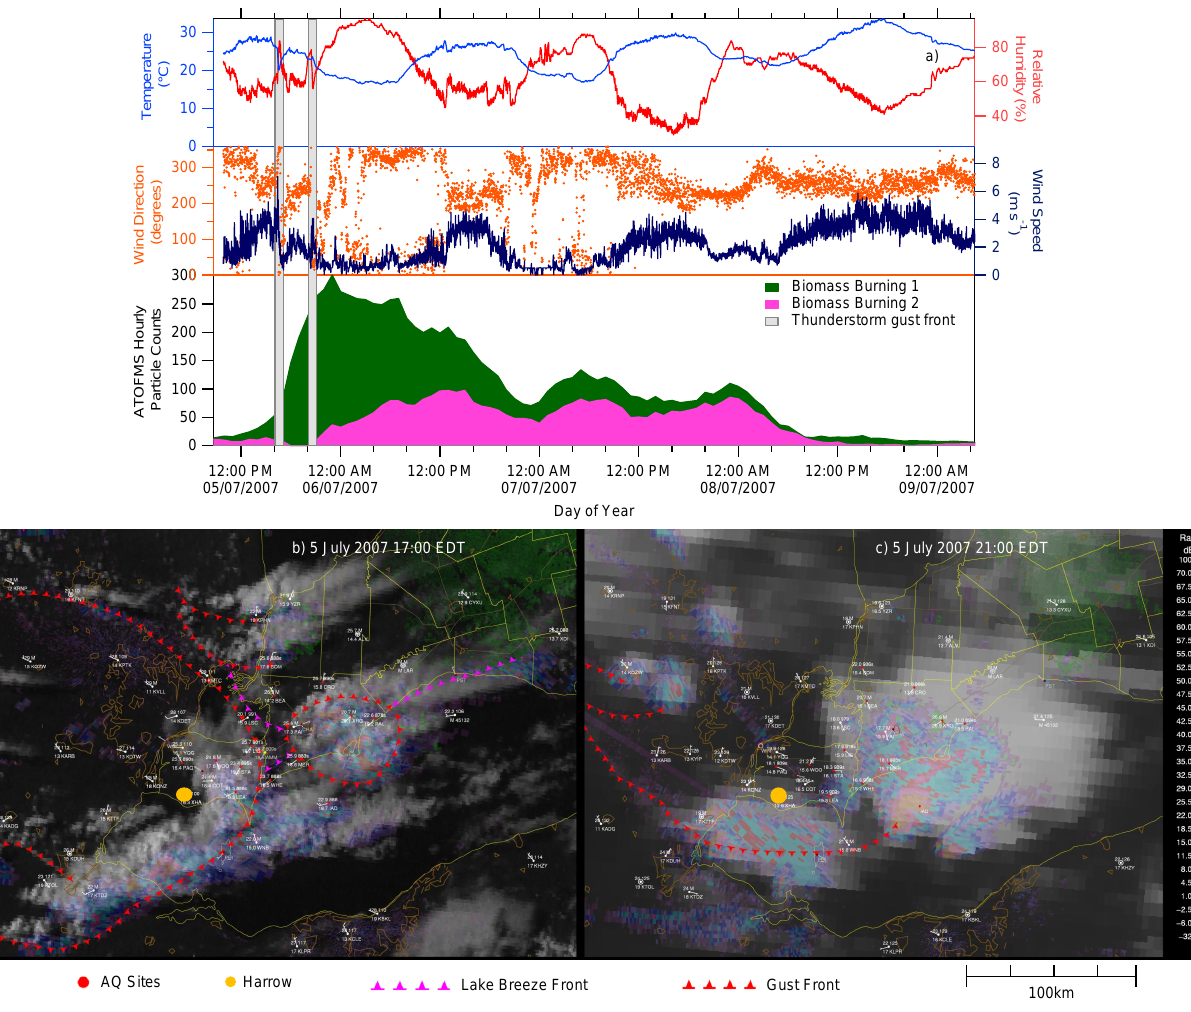
Fig. 9. Stacked time series of the two Biomass Burning factors (a) , and meso-analysis images showing the passage of two thunderstorm gust fronts over Harrow on 5 July 2007 at 17:00 EDT (b) and 21:00 EDT (c)